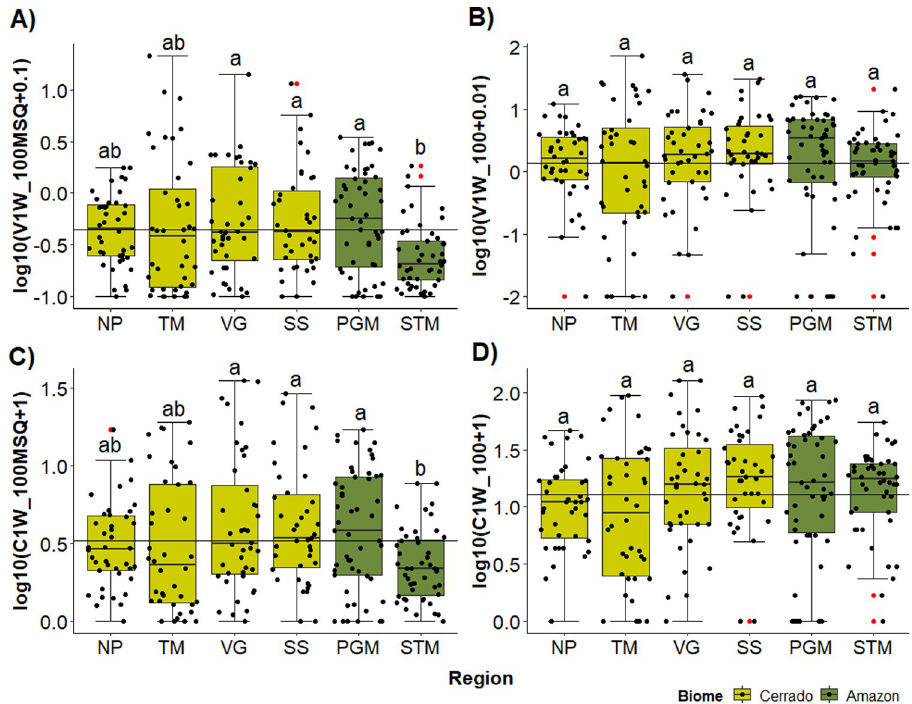
Fig 4. Boxplots of the instream wood quantities per region. Large wood (LW) volume per 100 m 2 —V1W_100MSQ (A), LW volume per 100 m (V1W_100) (B), LW pieces per 100 m 2 (C1W_100MSQ) (C), and LW pieces per 100 m (C1W_100) (D), all metrics in logarithmic scale for the six studied regions. The line crossing the chart represents the mean for all regions. In the boxplots the line represents the median, the box is the first (25%) and the third (75%) quartiles, the whiskers extend to the most extreme data point which is no more than 1.5 times the length of the box away from the box, the red dots are the outliers defined by the ‘1.5 rule’, the black dots show the values of each stream. The colours in the boxes indicate the biome where each region is located. Different letters next to whiskers indicate which groups differed in post–hoc comparisons (Tukey’s test).